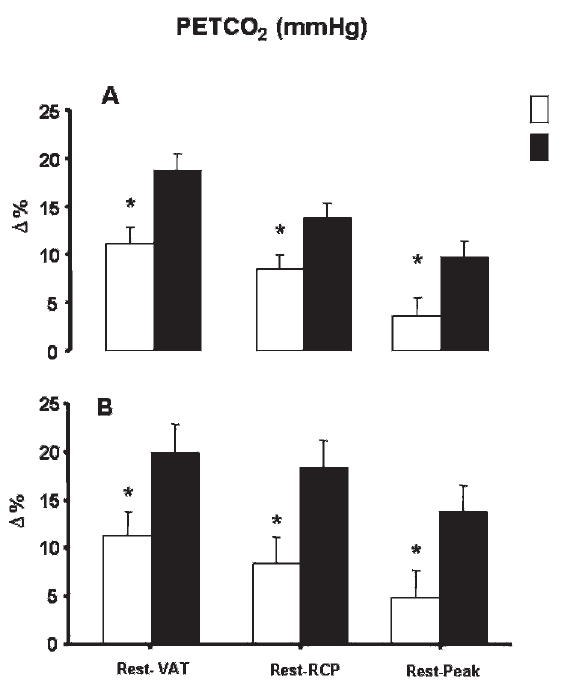
Figure 2 - Percentage difference from rest to ventilatory anaerobic threshold (rest/VAT), rest to respiratory compensation point (rest/RCP) and rest to peak of exercise (rest/Peak) in patients with coronary artery disease subjected to continuous exercise training (panel A) and interval exercise training (panel B). VAT=ventilatory anaerobic threshold; RCP=respiratory com- pensation point. * p , 0.05 vs. post-intervention.